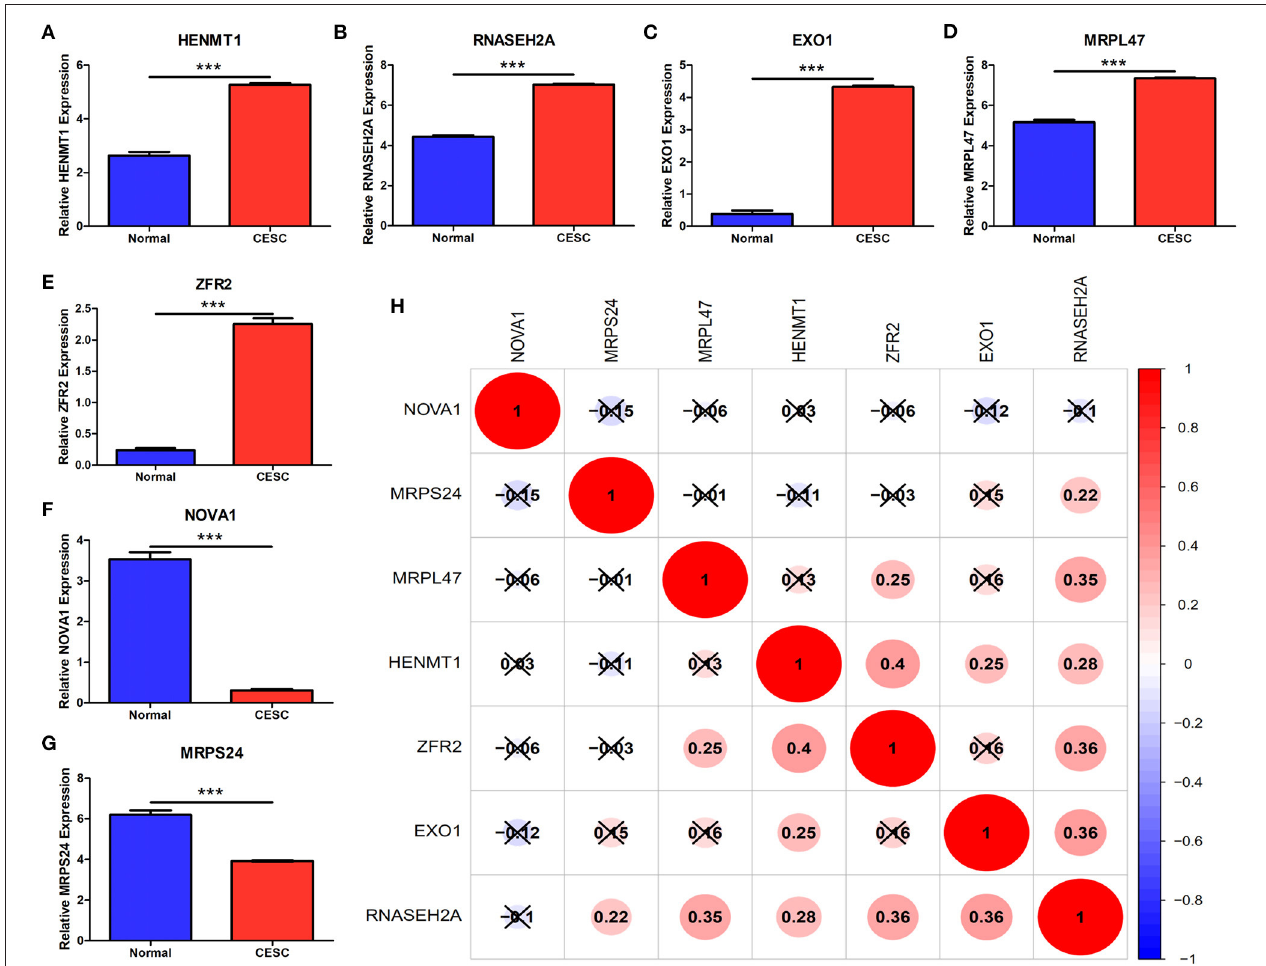
FIGURE 9 | Differences in gene expression of seven RBPs between CESC and normal samples in the database. (A) HENMT1. (B) RNASEH2A. (C) EXO1. (D) MRPL47. (E) ZFR2. (F) NOVA1. (G) MRPS24. (H) Expression correlation analysis of seven RBPs. *** P <